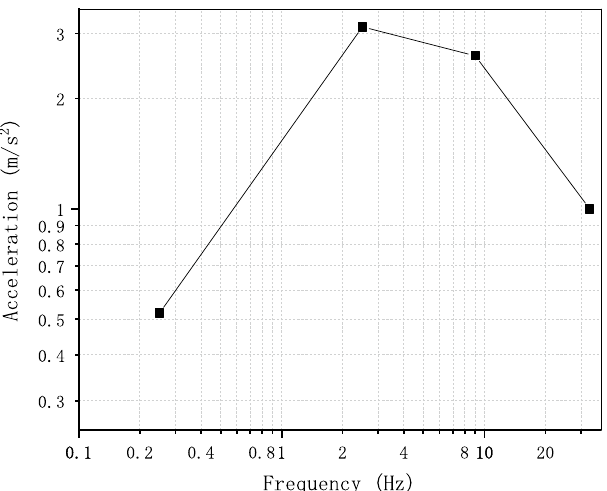
Figure 19. Desigen response acceleration spectrum defined by RG 1.60.